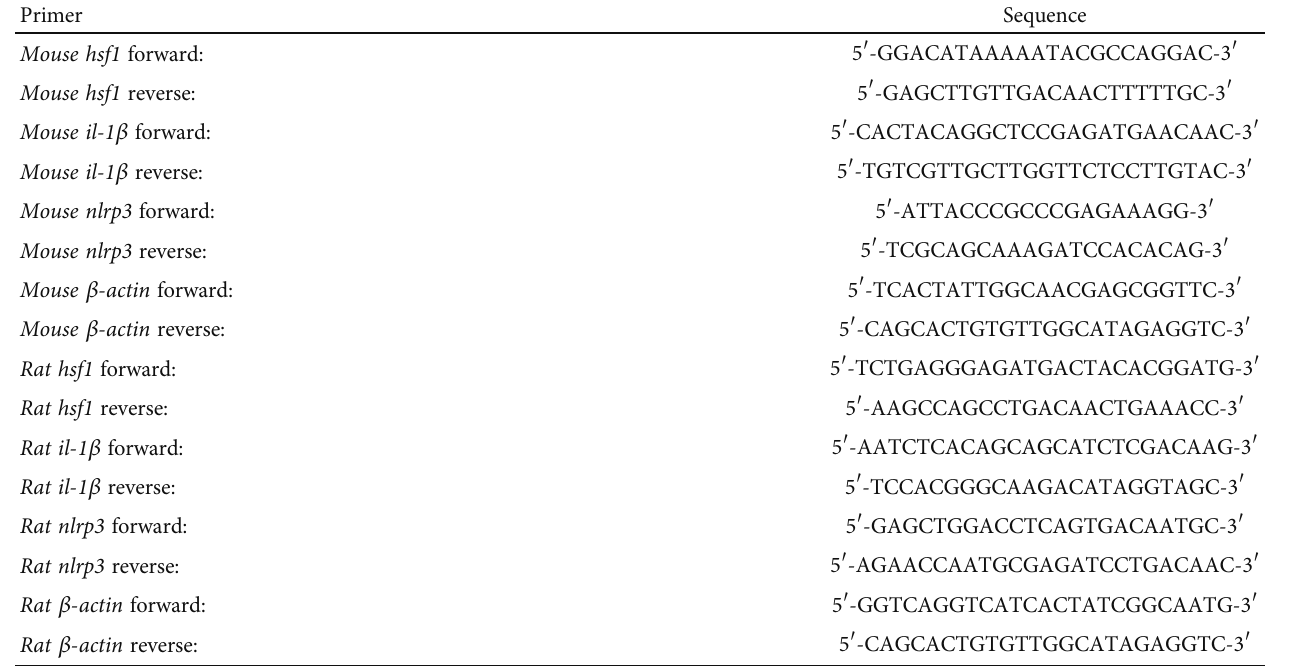
Table 1: The primer sequences used for